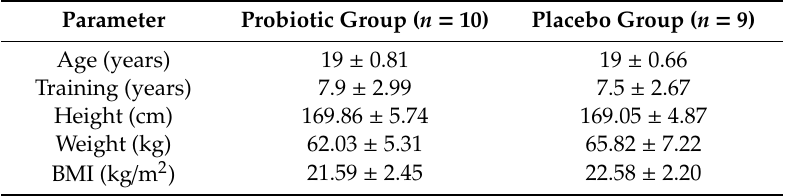
Table 1. Physical characteristics measurements of the football players at the